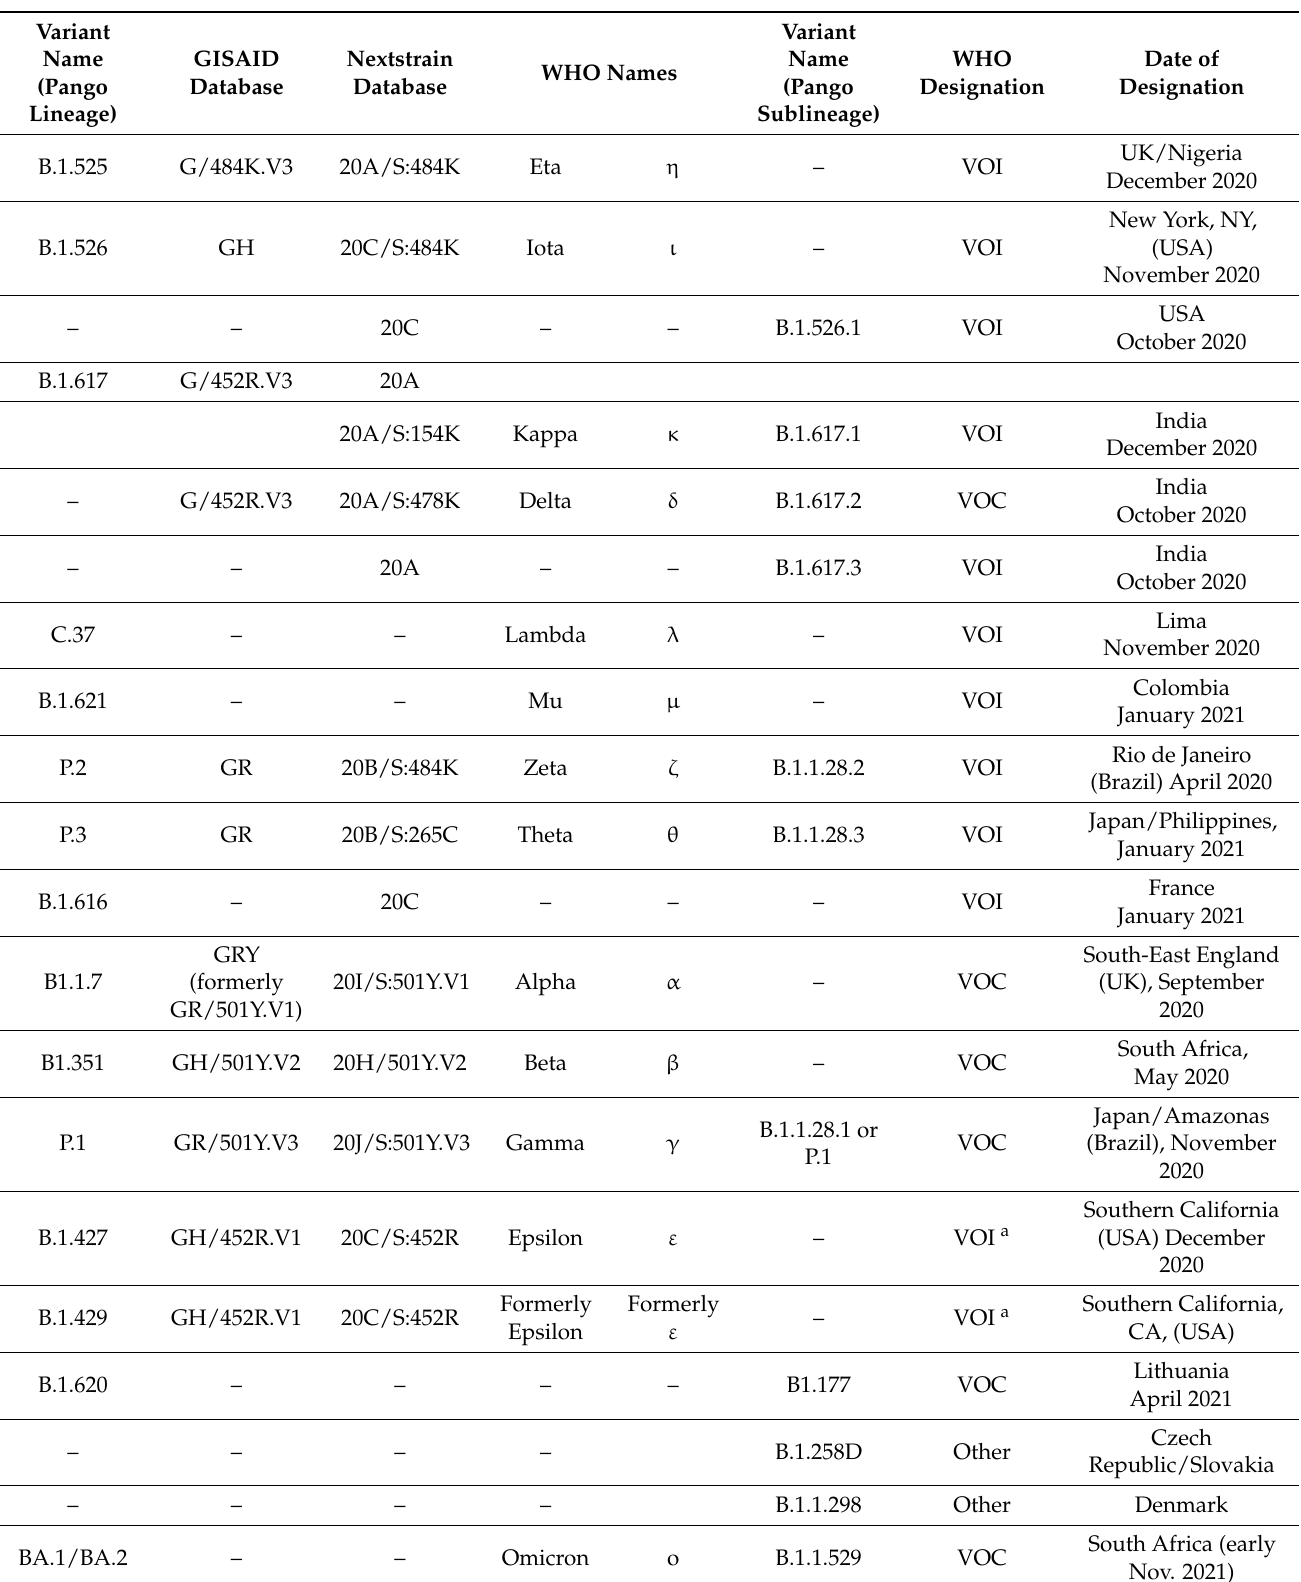
Table 1. Variants of